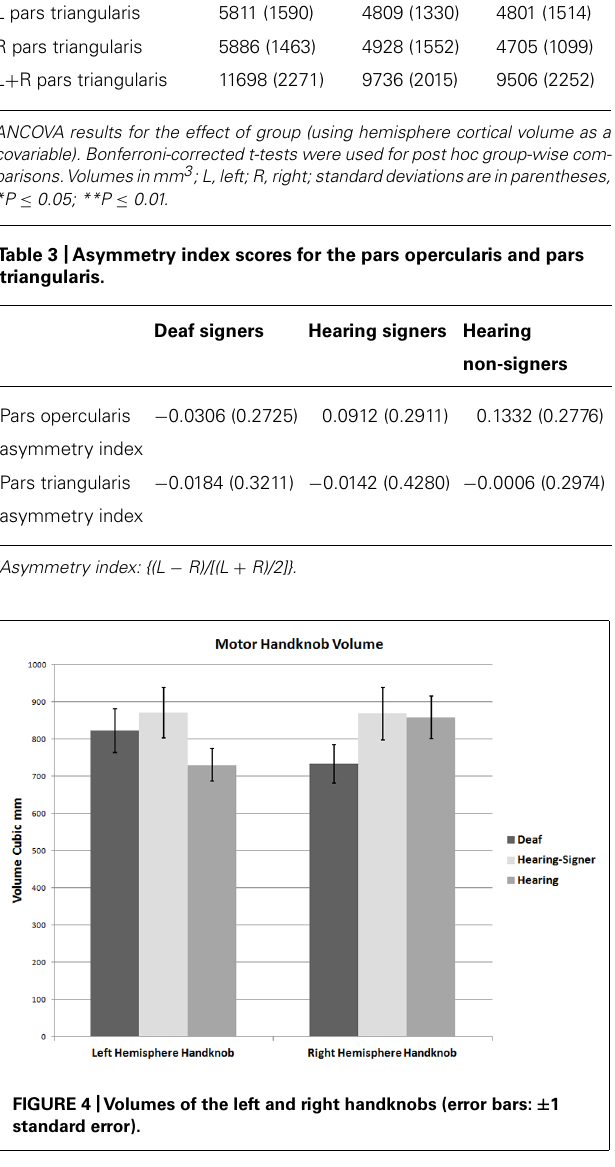
the AI score was significantly different between the two groups ( F = 5.243; df = 1,47; p = 0.027).